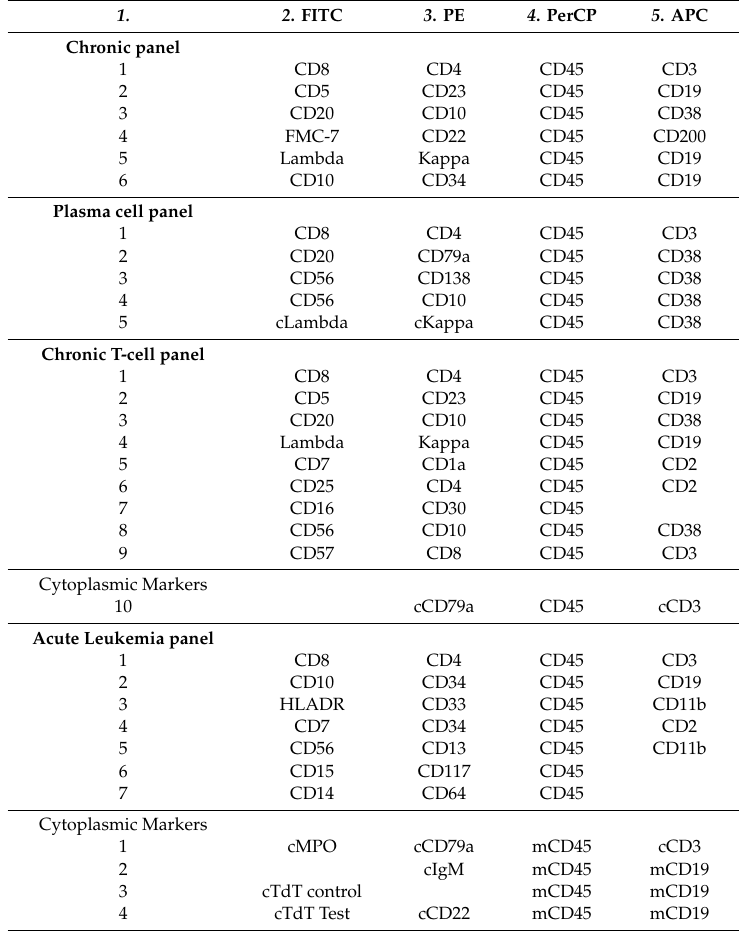
Table 1. Four-color panels column 1: tubes containing the four monoclonal antibodies conjugated to the respective fluorescent dyes. Column 2, 3, 4, 5: represent the fluorescent dyes.